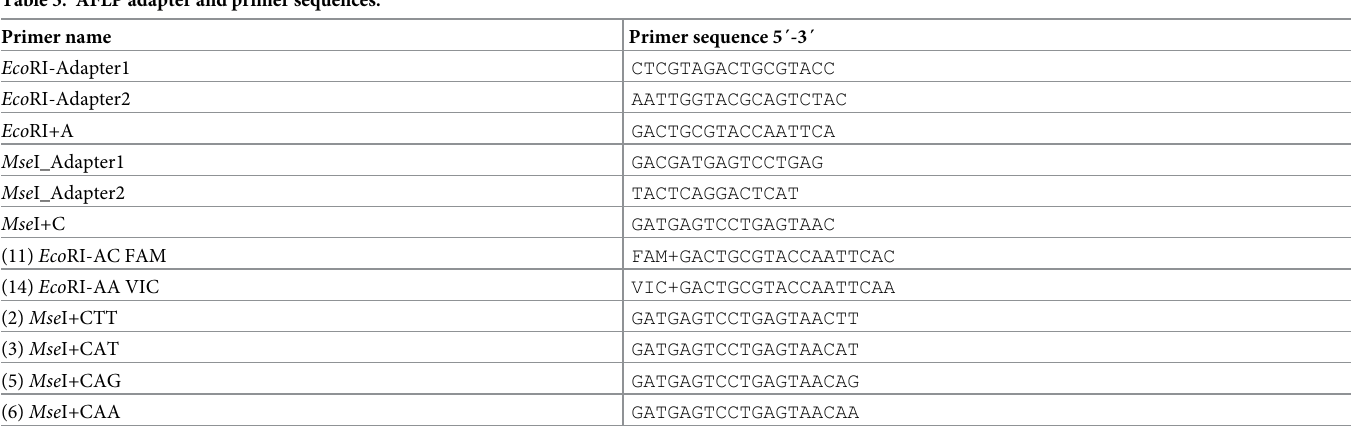
Table 3. AFLP adapter and primer